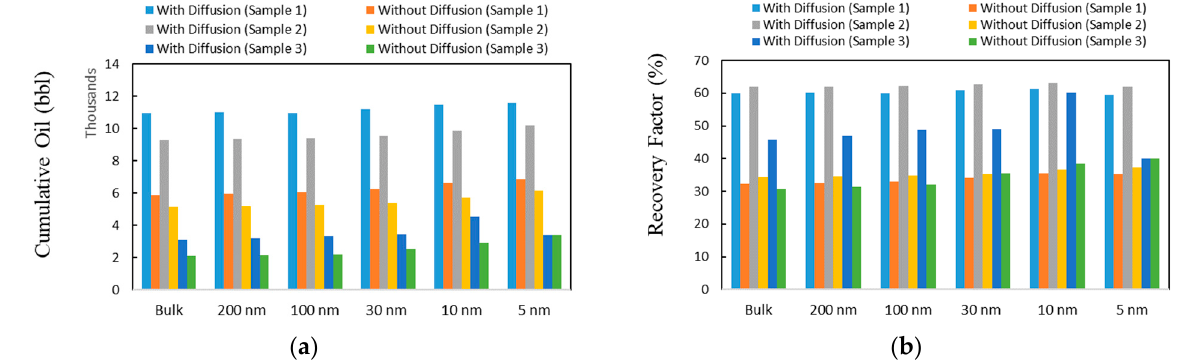
Figure 17. Effect of diffusion in ( a ) cumulative oil production and ( b ) recovery (%) in CO 2 HnP scenario for fluid samples at different pore confinement.